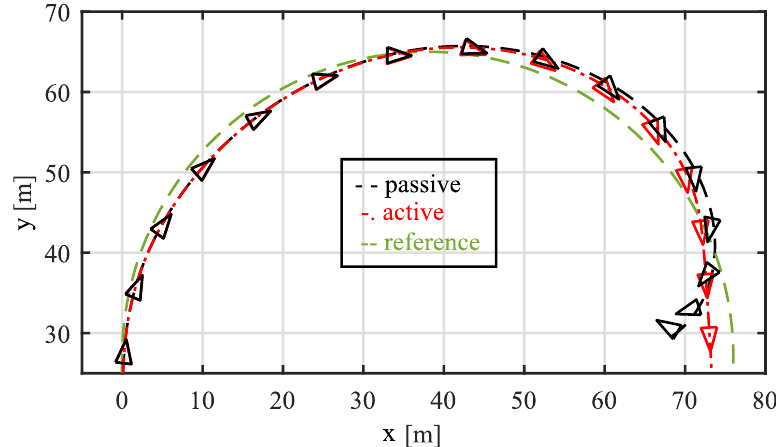
Figure 12. U-turn, low-skilled driver, vehicle cog trajectory. Triangles represent the orientation of vehicle x -axis starting from the vehicle cog.